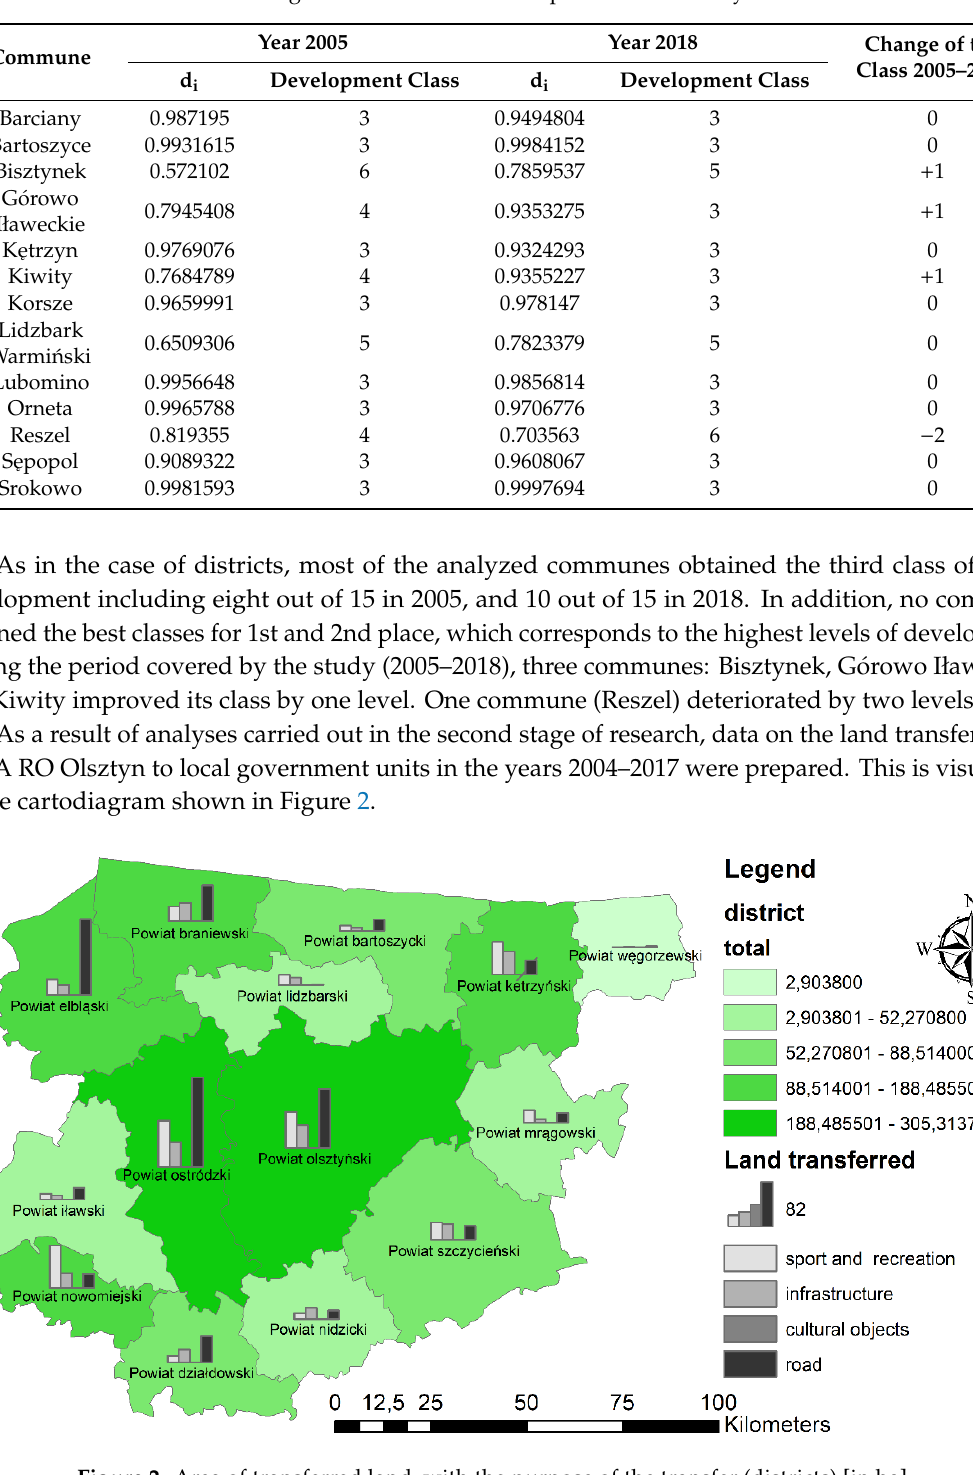
Figure 2. Area of transferred land, with the purpose of the transfer (districts) [in ha].